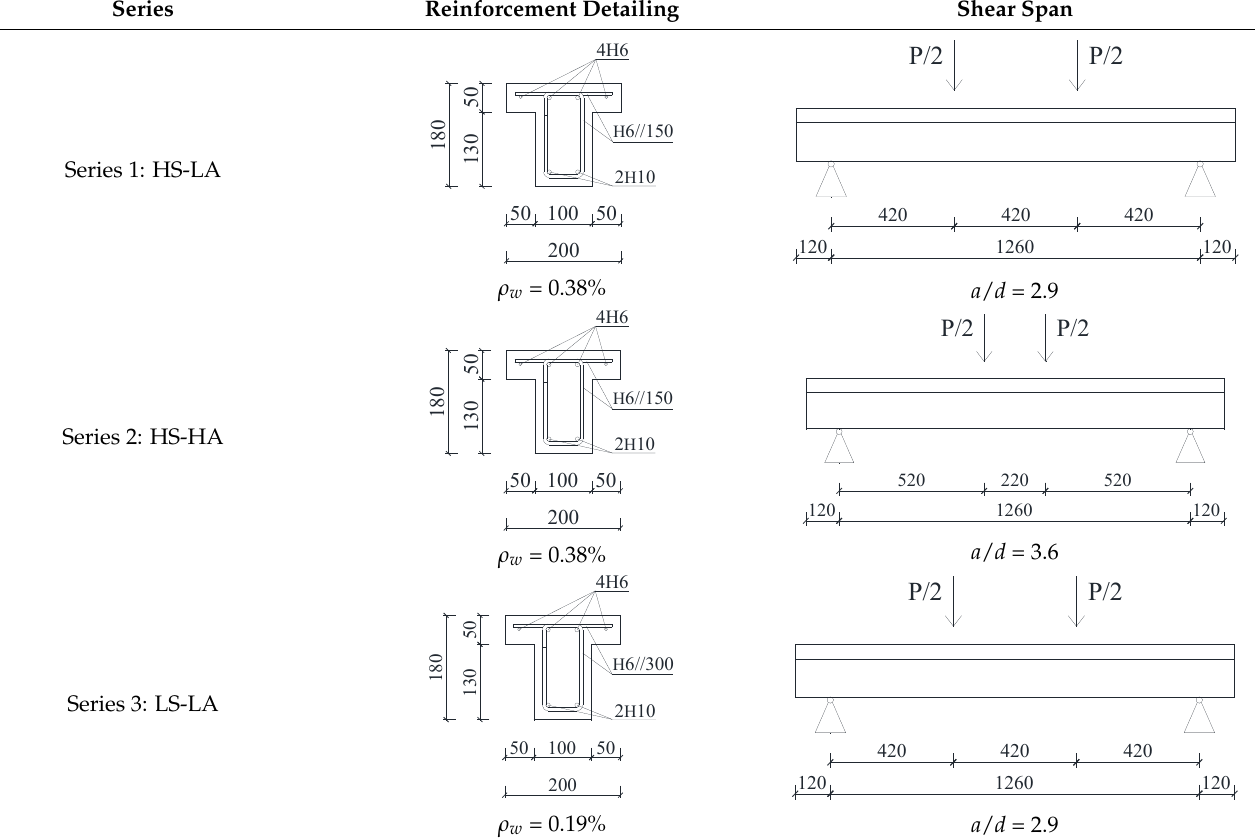
Figure 1. Summary of test parameters. 2.2. Materials For composite strengthening, unidirectional CFRP sheets and a carbon mesh (20 mm mesh size) were used for the TRM application. The main properties, including the fibre weight per unit area, the nominal thickness t f defined by the ratio weight/density, as well as the elastic modulus E f from coupon tests are found in Table 2. The FRP composite was applied to the surface of the concrete specimen using the wet-layup procedure recommended by the manufacturer. For the TRM, a mortar with characteristic compressive strength of 45 MPa (28 days), a characteristic flexural strength of 6 MPa and a characteristic elastic modulus of 30 GPa was used in a thick layer application of ca. 20 mm, following the manufacturer's guidelines. Table 2. Material properties of carbon FRP sheets and textile.